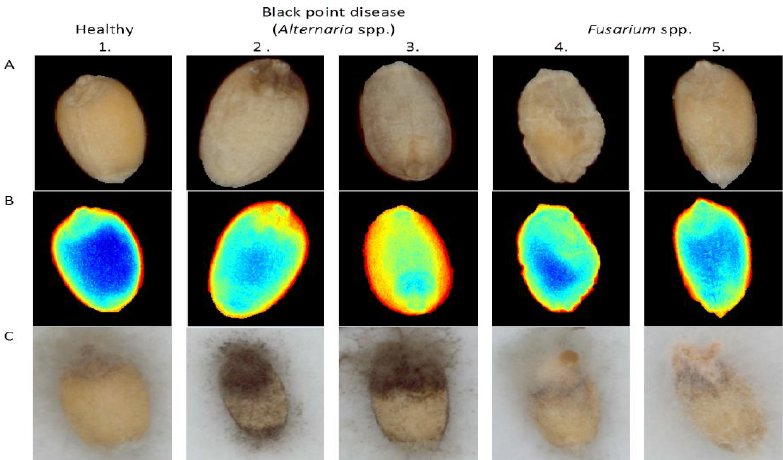
Figure 7. Difference between healthy and infected seeds by black point disease ( Alternaria sp.) and Fusarium sp. ( A ) RGB-captured images, ( B ) nCDA-transformed images, and ( C ) RGB images after seed incubation (adapted from Vrešak et al. [81] ) .